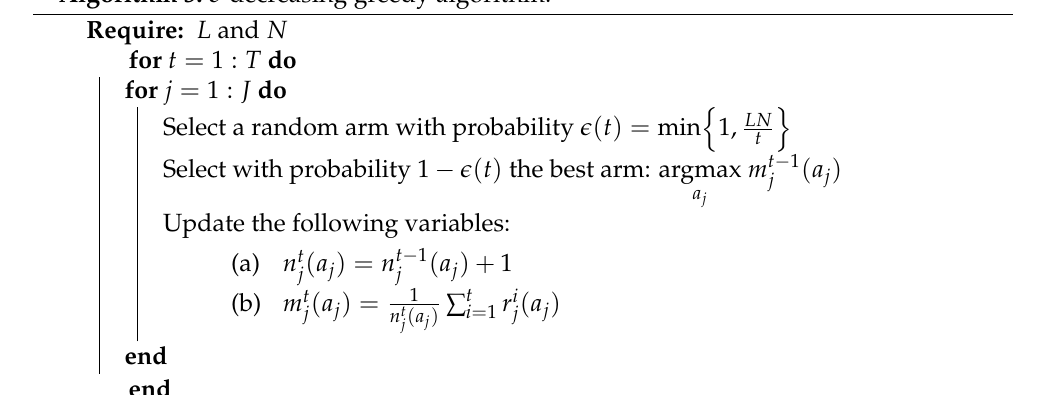
Algorithm 3: (cid:101) -decreasing greedy algorithm.